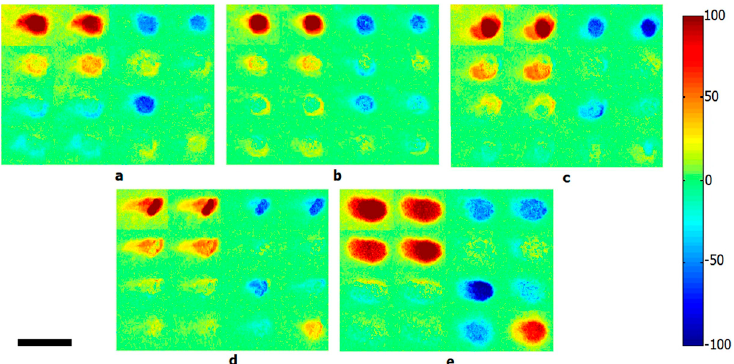
Figure 8. Calculated backscattering Mueller matrix images of five different bacterial colonies: ( a ) Escherichia coli , ( b ) Lactobacillus rhamnosus , ( c ) Rhodococcus erythropolis , ( d ) Staphylococcus aureus , and ( e ) bacteria-free Luria broth agar media. Scale bar is 2 mm. Reprinted with permission from [187]. Copyright © 2020, published by Springer Nature.